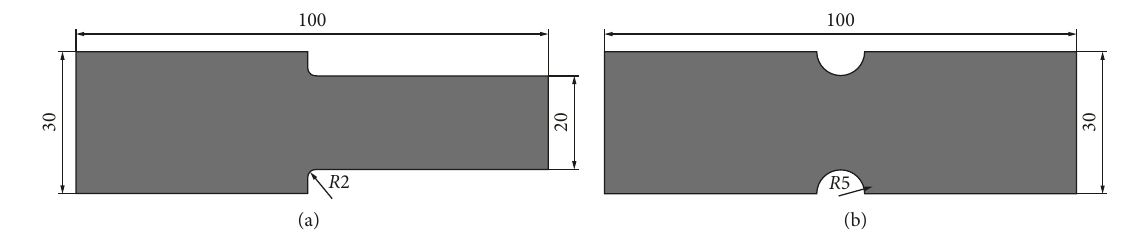
Figure 2: Specimens dimensions for fatigue tests (mm): (a) fillet and (b) notched.